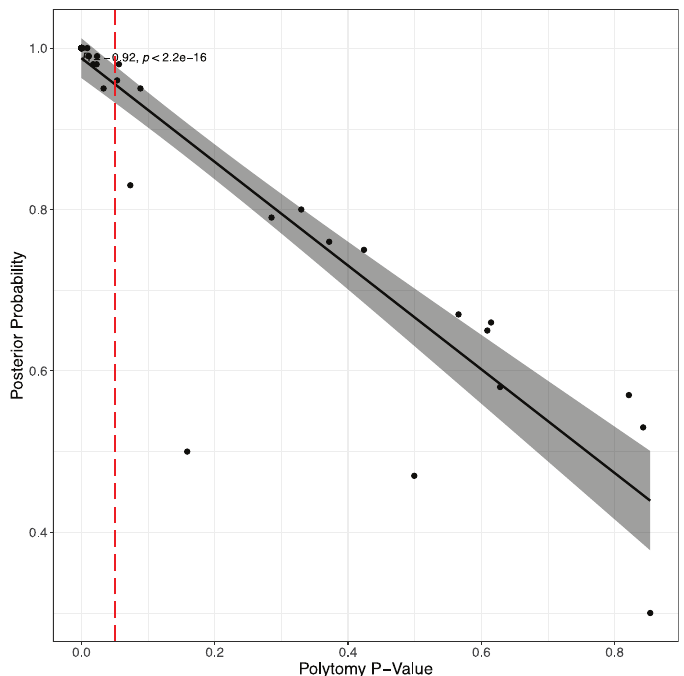
Figure 6. Pearson correlation showing the relationship between polytomy p -value and PP (gene tree analysis). We visualise the branches for which the polytomy null model could be rejected, based on the ASTRAL polytomy test at p < 0.05, indicated by the red dashed